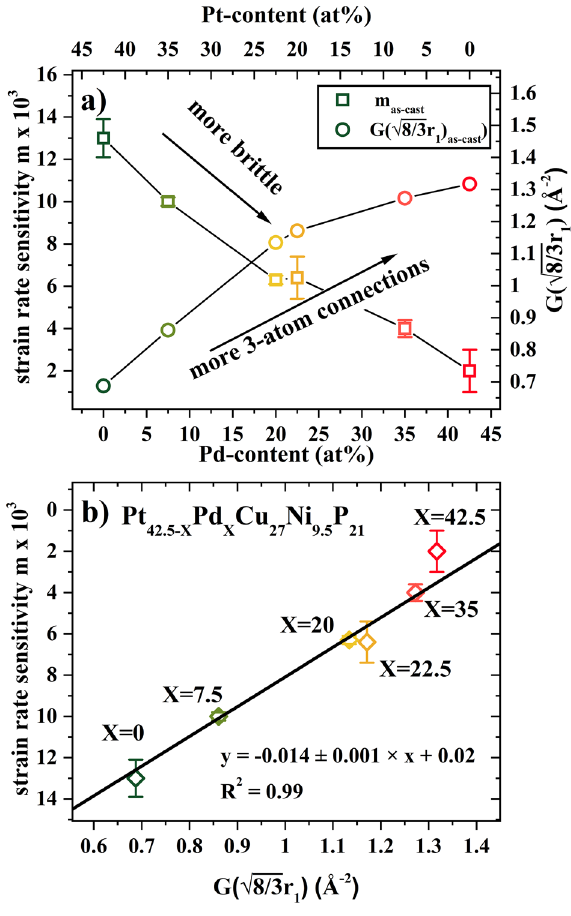
Figure 7. ( a ) Strain rate sensitivity m for as-cast state as a function of Pd-content (left axis, open squares) and absolute value of reduced pair distribution function at the length scale of 3-atom connections G( √ 8 / 3 r 1 ) in the as-cast state as a function of Pd-content (right axis, open circles). A decrease in SRS with increase in Pd content, associated with more brittle behavior, is observed. More rigid 3-atom connections in the reduced pair distribution function are observed with increase in Pd content, which is also characteristic of relatively brittle behavior. ( b ) Scatter plot of m as-cast and G( √ 8 / 3 r 1 ) as-cast showing the correlation of decreasing strain-rate sensitivity with increasing fraction of 3-atom cluster